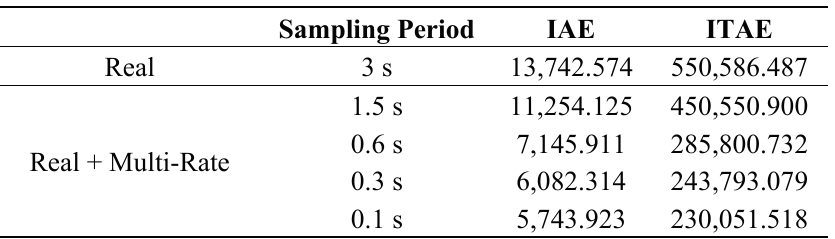
Table 3. Performance indexes of the WNCS For real sampling of 3 s and soft sensor and multi-rate of 1.5, 0.6, 0.3 and 0.1 s.